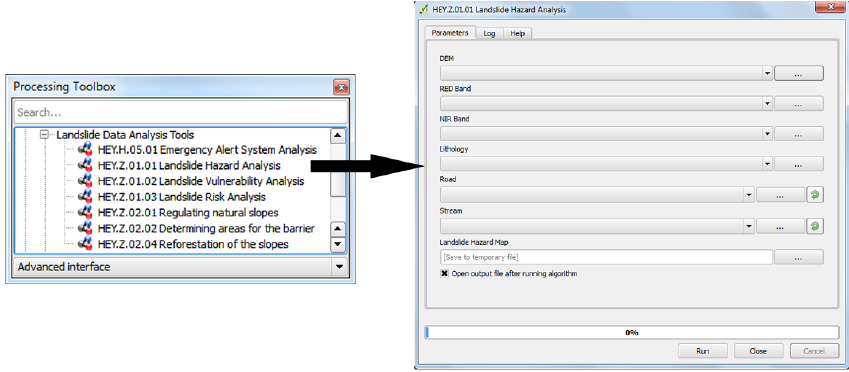
Figure 6. ADYS analysis toolbox and user interface of HEY.Z.01.01